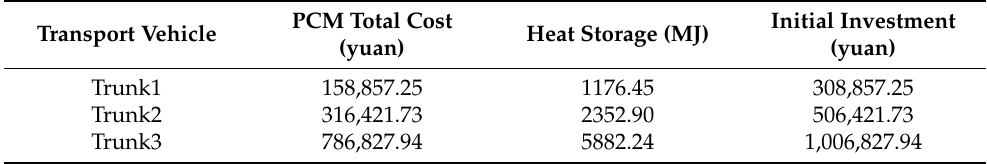
Table 6. Cost and heat storage of different transport vehicles.